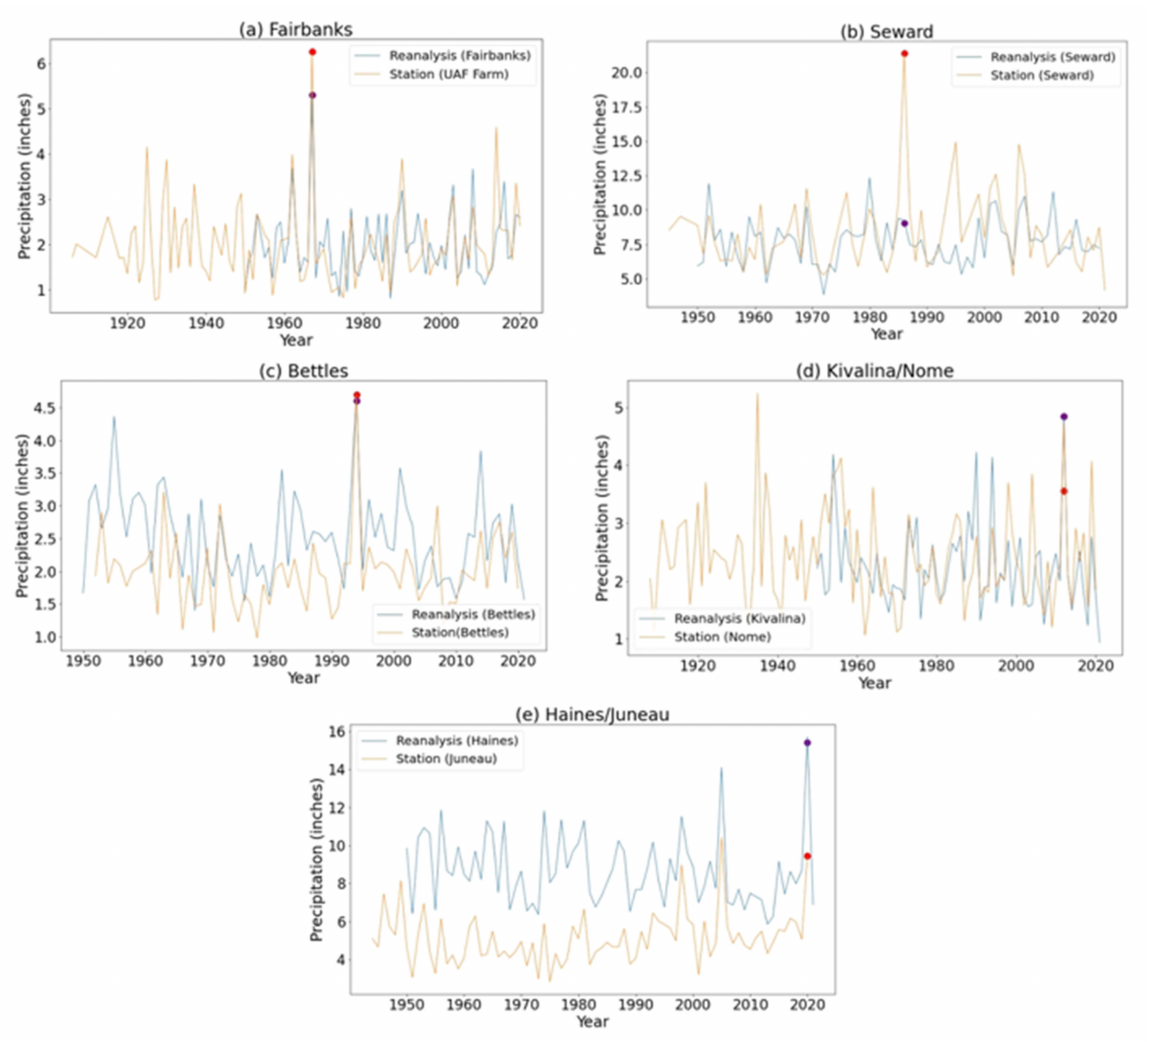
Figure 7. As in Figure 5, but for yearly maximum 7 day precipitation at the locations of the five flood events: ( a ) Fairbanks, ( b ) Seward, ( c ) Bettles, ( d ) Kivalina/Nome and ( e )